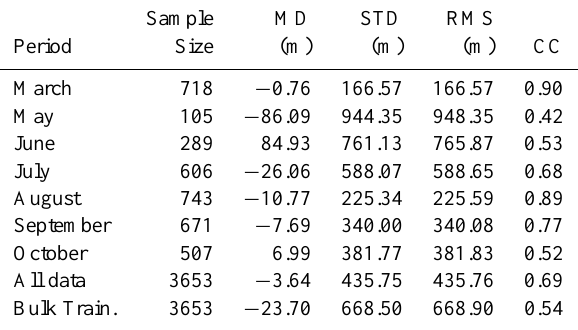
Table 2. Statistics for the comparison between 1h average MLH es- timated by MWR and lidar observations. The sample size (SS), the mean difference (MD), the standard deviation (STD), the root mean square (RMS), and the correlation coefficient (CC) are